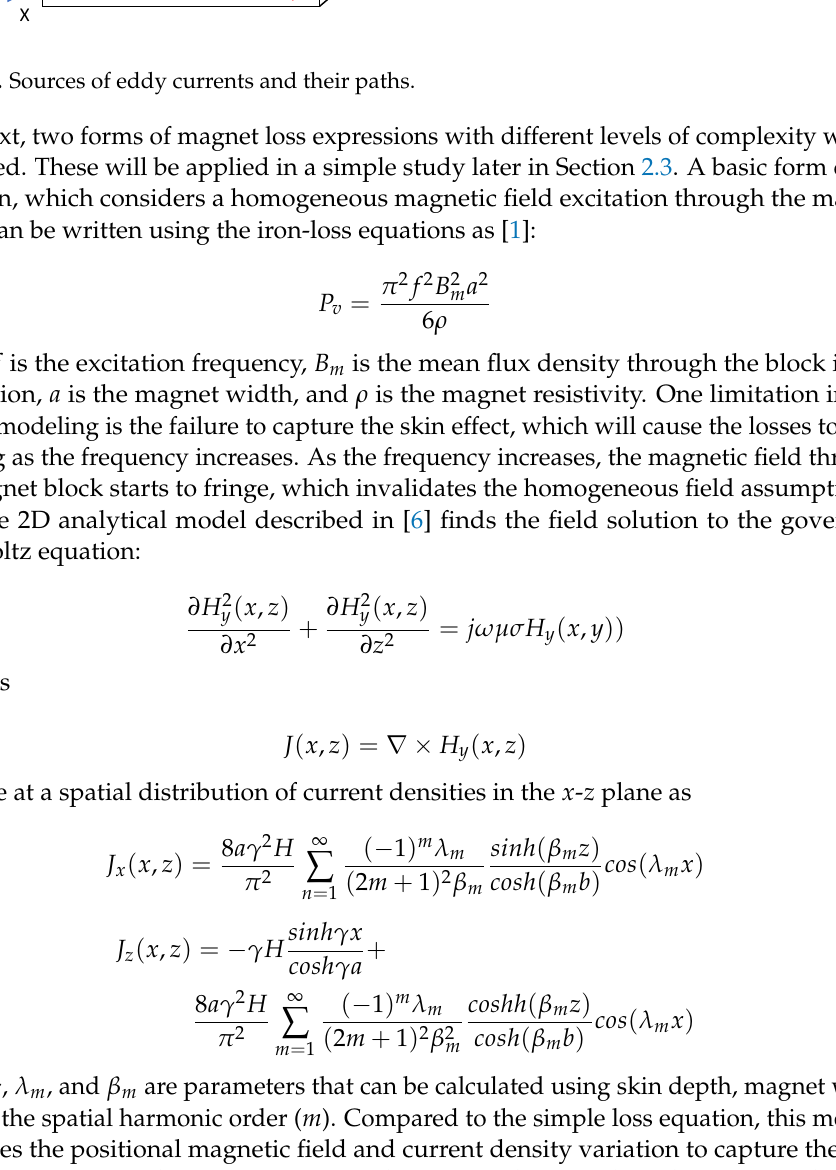
Figure 2. Sources of eddy currents and their